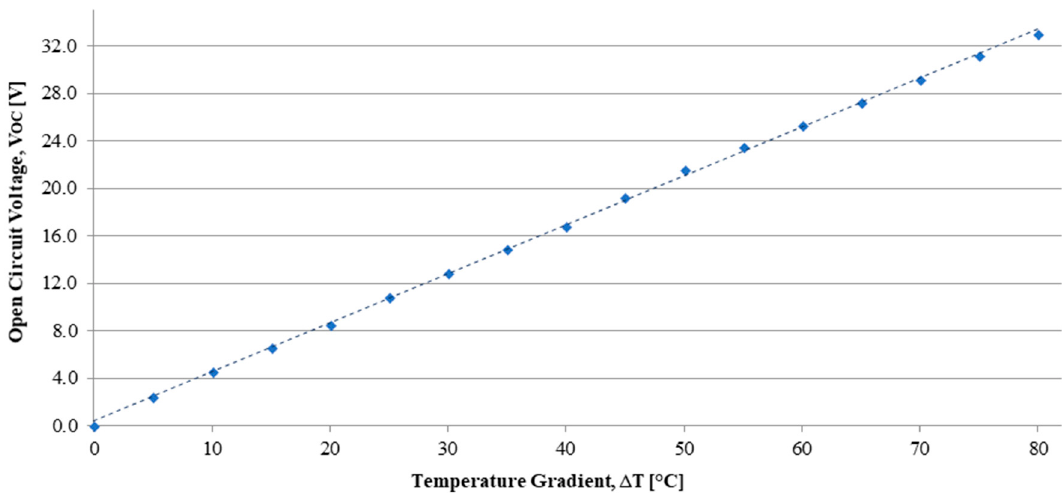
Figure 2. Results obtained in the open circuit test (INBC1-127.08HTS).